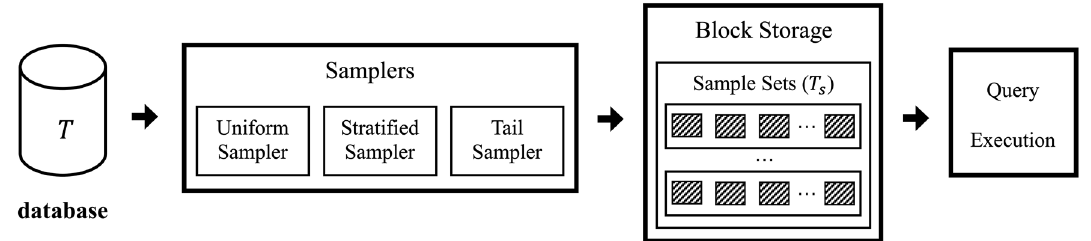
Fig. 2 The storage form of samples in